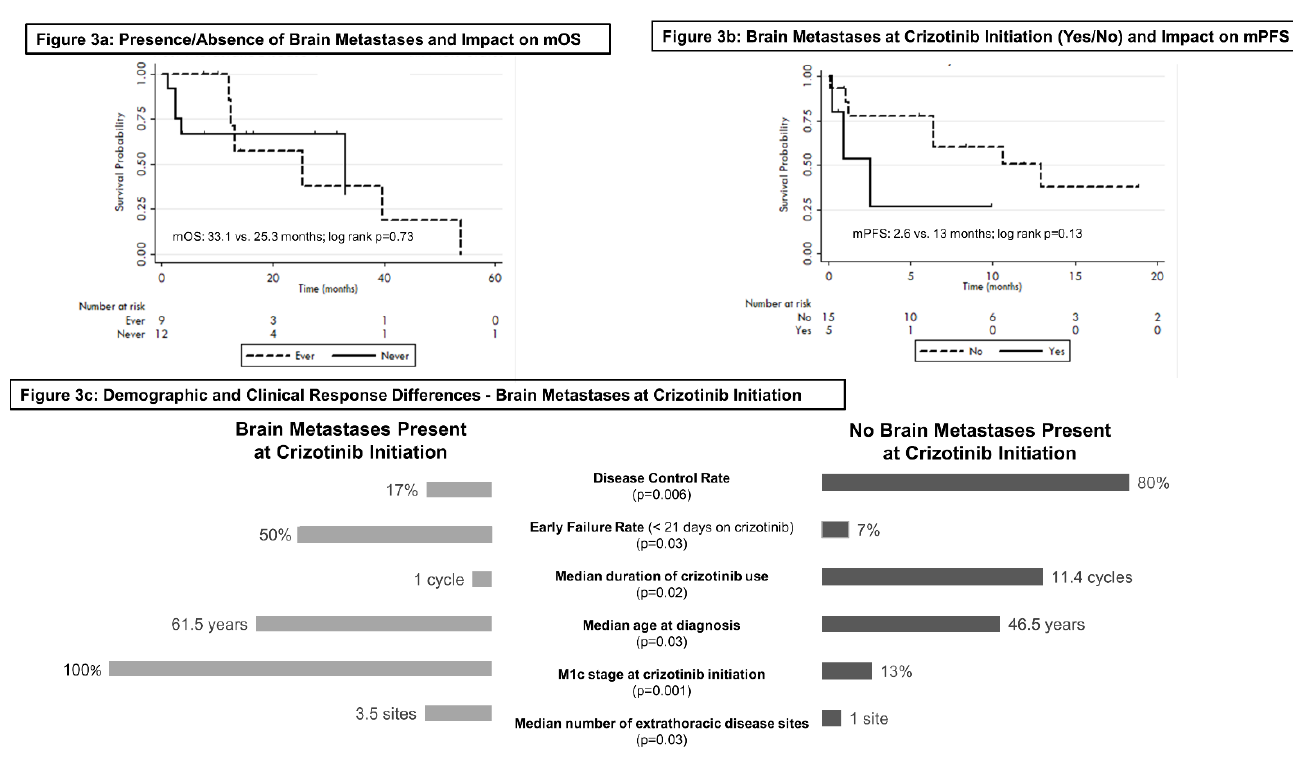
Figure 3. Brain metastases and crizotinib: presence/absence of brain metastases and impact on mOS ( a ); impact of brain metastasis at time of crizotinib initiation and impact on mPFS ( b ); demographic and clinical response differences of patients with/without brain metastases at crizotinib initiation ( c ).